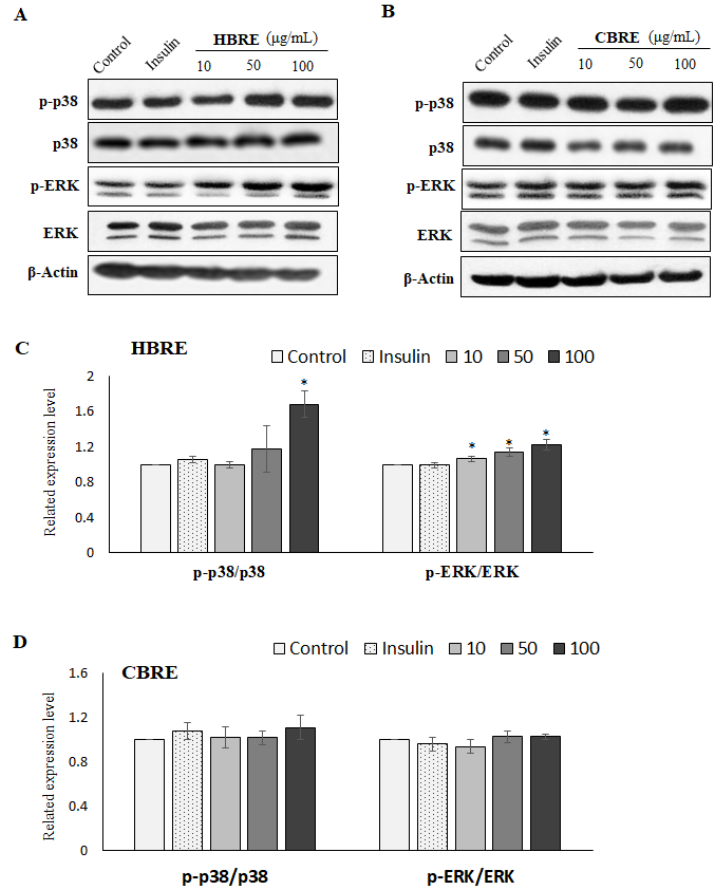
Figure 6. Effect of black rice extracts on protein expression of p38/ERK signaling in C2C12 myotubes. Cells were treated with indicated concentrations of ( A , C ) HBRE and ( B , D ) CBRE for 24 h, and the representative immunoblot and quantification graphs were presented (means ± SD). * p < 0.05 vs. control group.